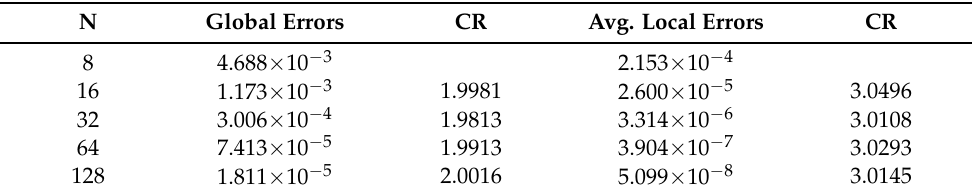
Table 3. Errors and convergence rate of Scheme 1 with the parameters of X 0 = 0.1, f ( 1 ) = 1.72,